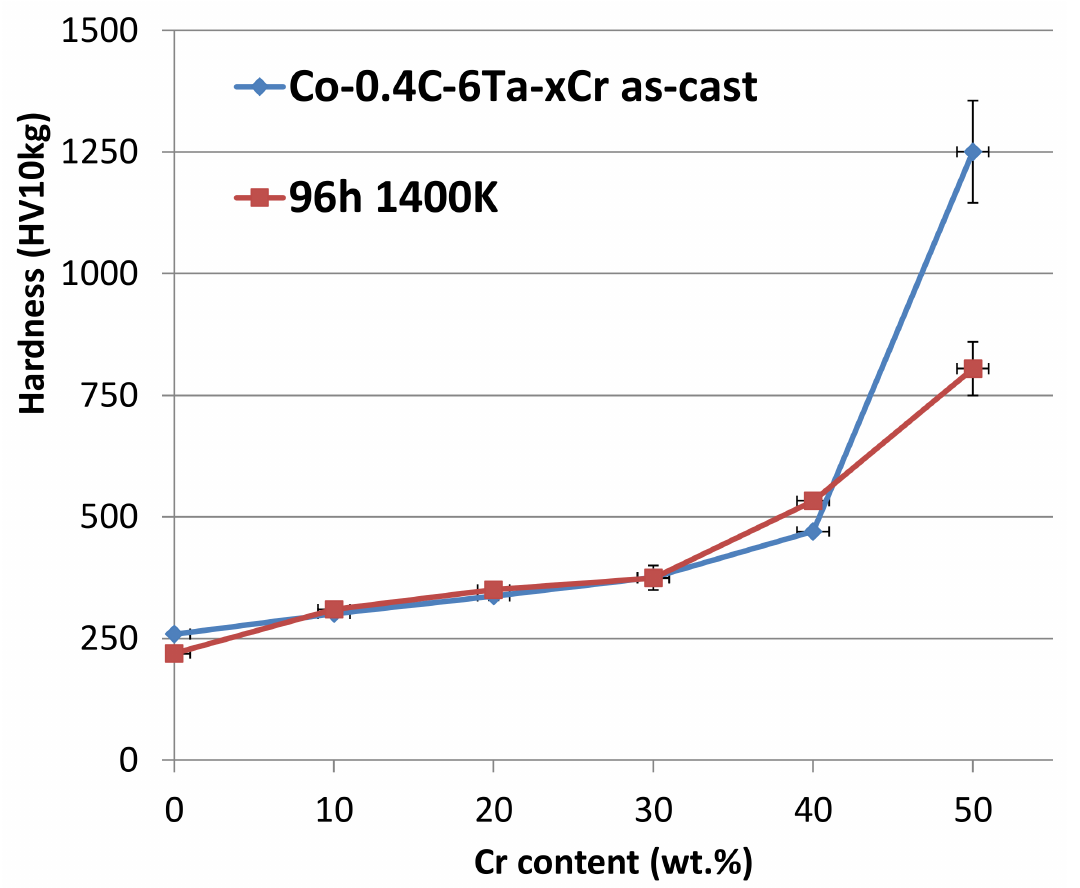
Figure 13. Hardness of the six alloys in their as-cast states and aged states, plotted versus the chromium content in the alloy (Vickers method, load: 10